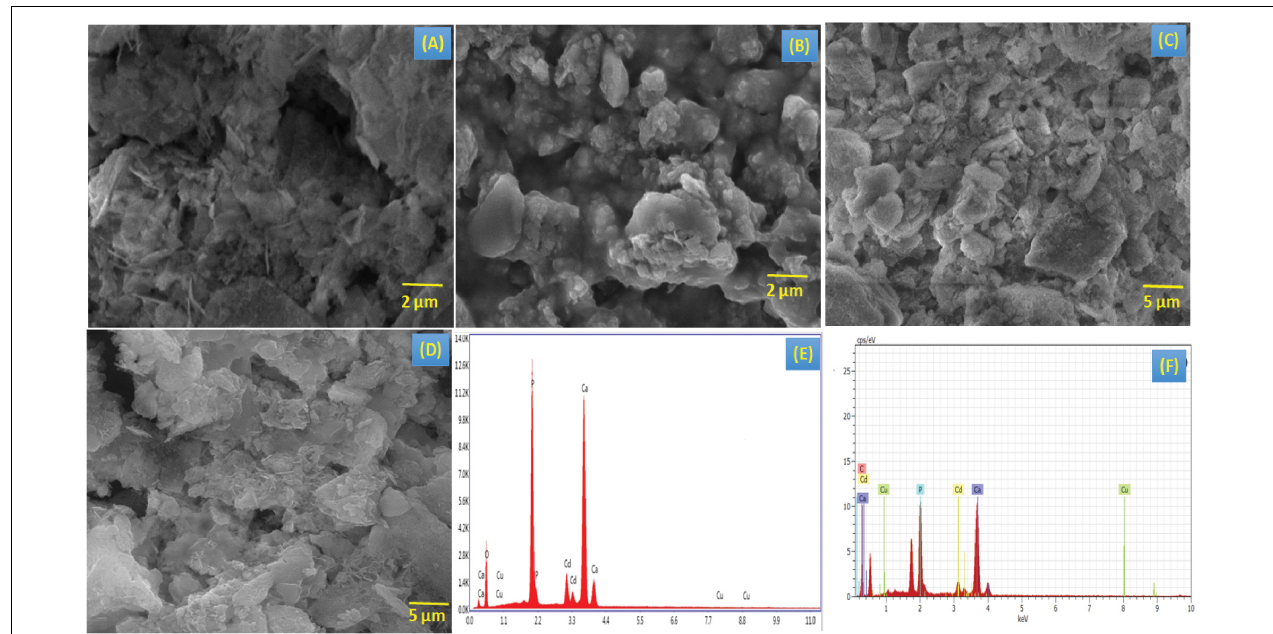
FIGURE 3 | SEM images of (A) HA, (B) BM-HA, (C) BM-HA/PAA, and (D) BM-HA/PAA/UMB composites and EDAX images of (E) BM-HA ceramic, and (F) BM-HA/PAA/UMB